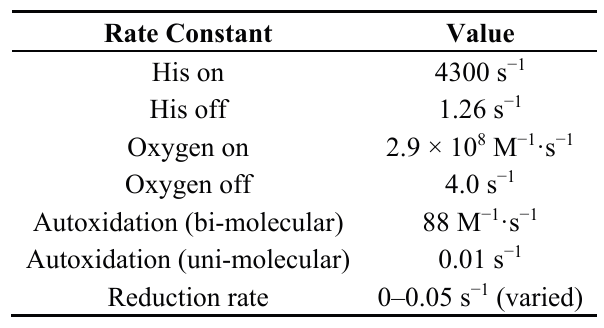
Table 1. Rate constants employed in modelling procedures.